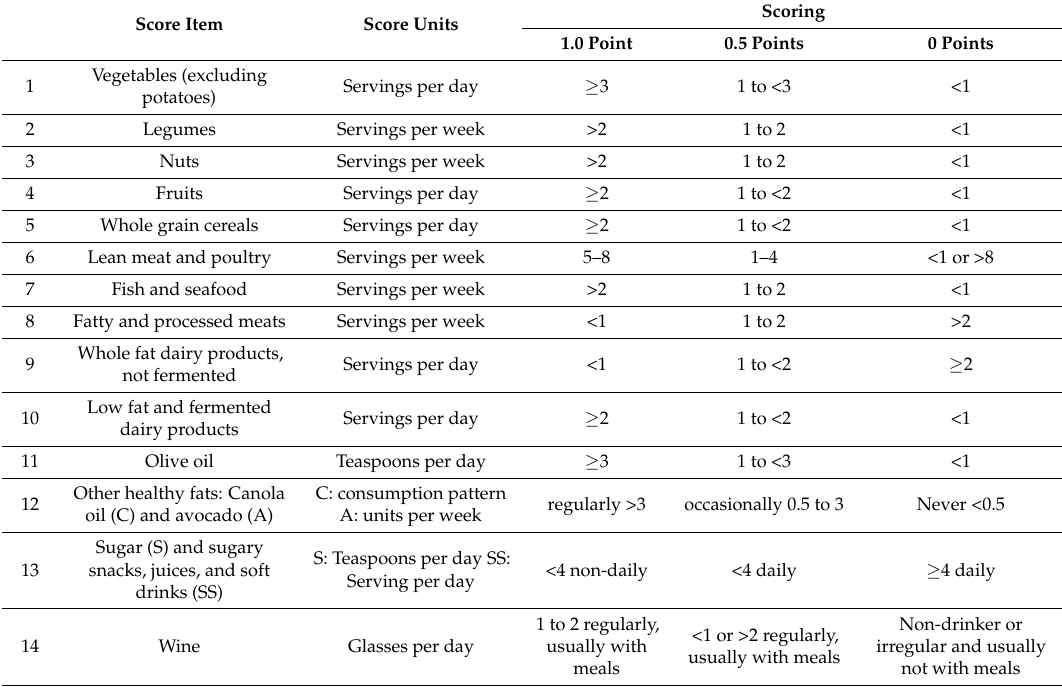
Table 1. Chilean Mediterranean Diet Index (Chilean-MDI) definition and scoring